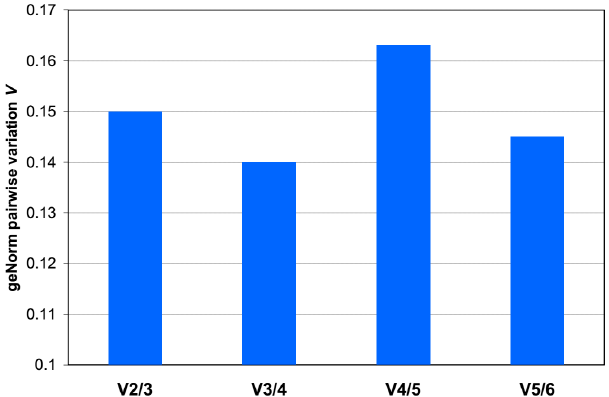
Figure 7. Pairwise variation analysis between normalization factors in the entire set of maternal blood samples. To determine the optimal number of reference genes required for accurate normalization, a pairwise variation ( V n/n+ 1 ) analysis was performed between the normalization factors NF n and NF n+ 1 , where n is the number of reference genes.